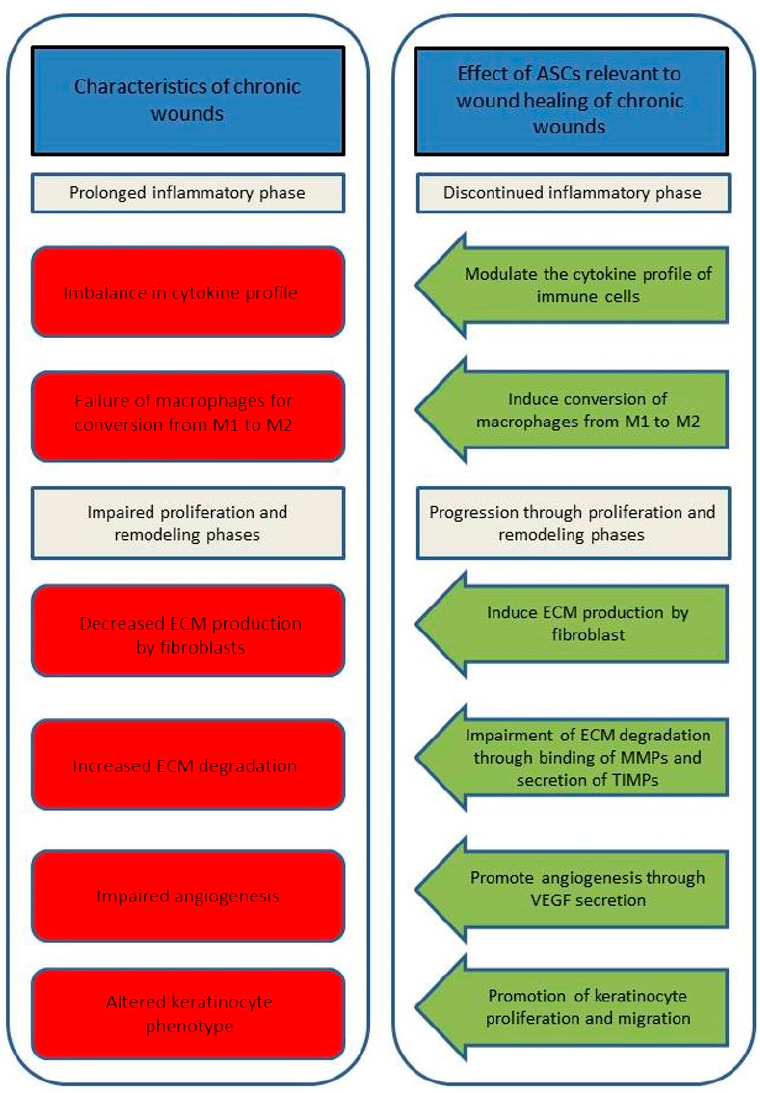
Figure 2. Characteristics of chronic wounds and the relevant regenerative effects of ASCs on these. Chronic wounds appear to unable to progress from the inflammatory phase of normal wound healing and to have impaired proliferation and remodeling phases ( left panel ). The ASCs have several regenerative characteristics that may lead to the wound progression from the inflammatory phase and through the proliferation and remodeling phases ( right panel ). ASC: adipose tissue-derived stem/stromal cells; MMP: matrix metalloproteinase; TIMP: tissue inhibitor of metalloproteinase; VEGF: vascular endothelial growth factor.